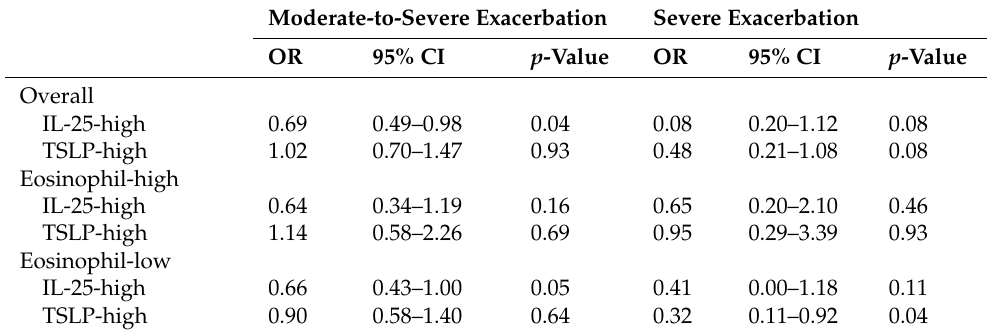
Table 4. Exacerbation risk according to IL-25 and